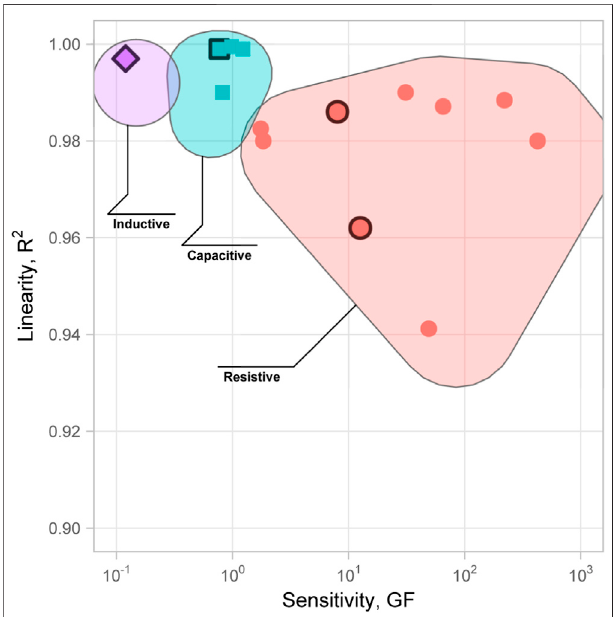
FIGURE 8 | The general trade-off between sensitivity, as measured by gauge factor, and linearity, as measured by R 2 of the linear fi t between signal and strain. Clustering between sensor types is suggested by bounding polygons. Examples from literature were chosen that had published GF and R 2 data (see Supplementary Table S9 for details) and the sensors fabricated in this research are highlighted with a black